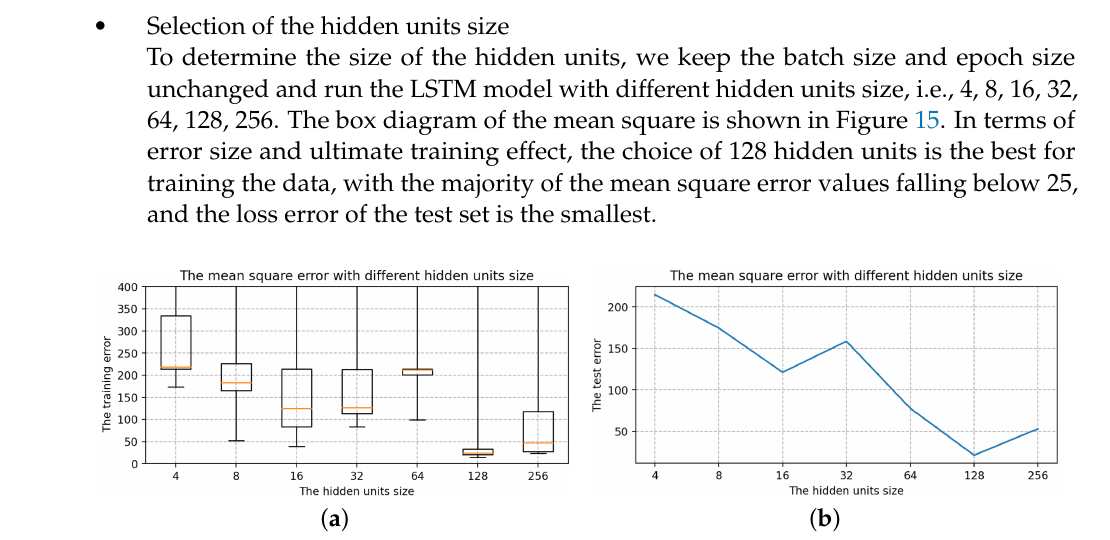
Figure 14. The mean square error with different numbers of LSTM layers. ( a ) The training error with different number of LSTM layers. ( b ) The test error with different number of LSTM layers.